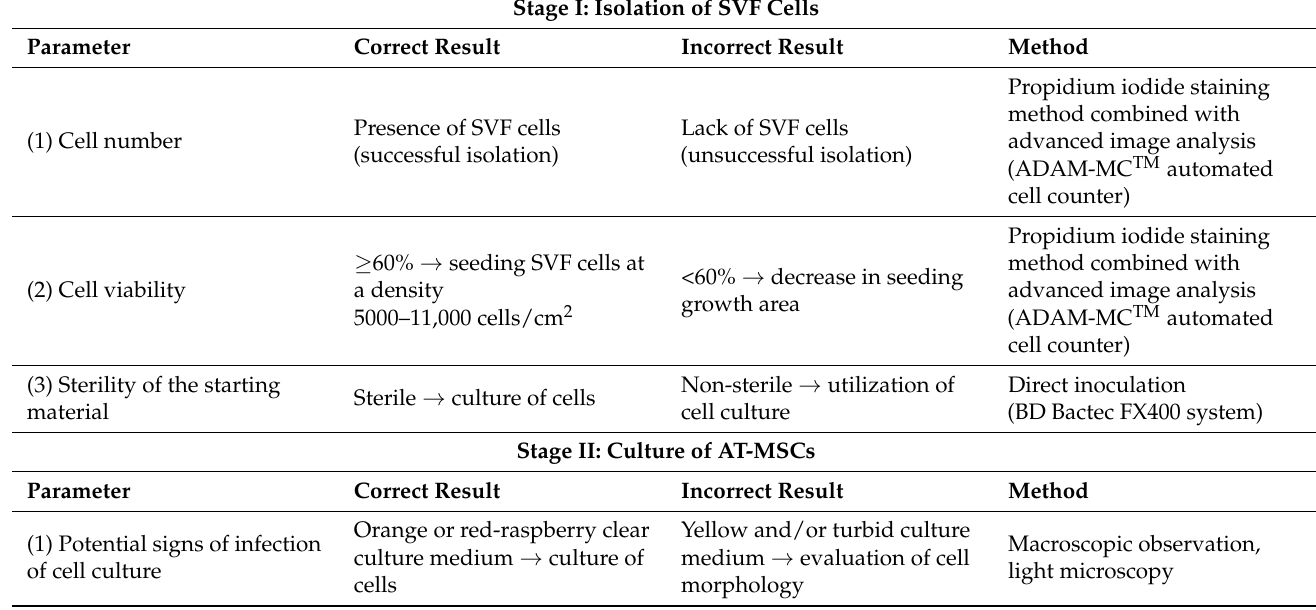
Table 1. In-process quality controls and acceptance criteria for the manufacturing of HE-ATMP. During the manufacturing process, we distinguished the following CPPs: the isolation of SVF cells, the culture of AT-MSCs, and the formulation of the final